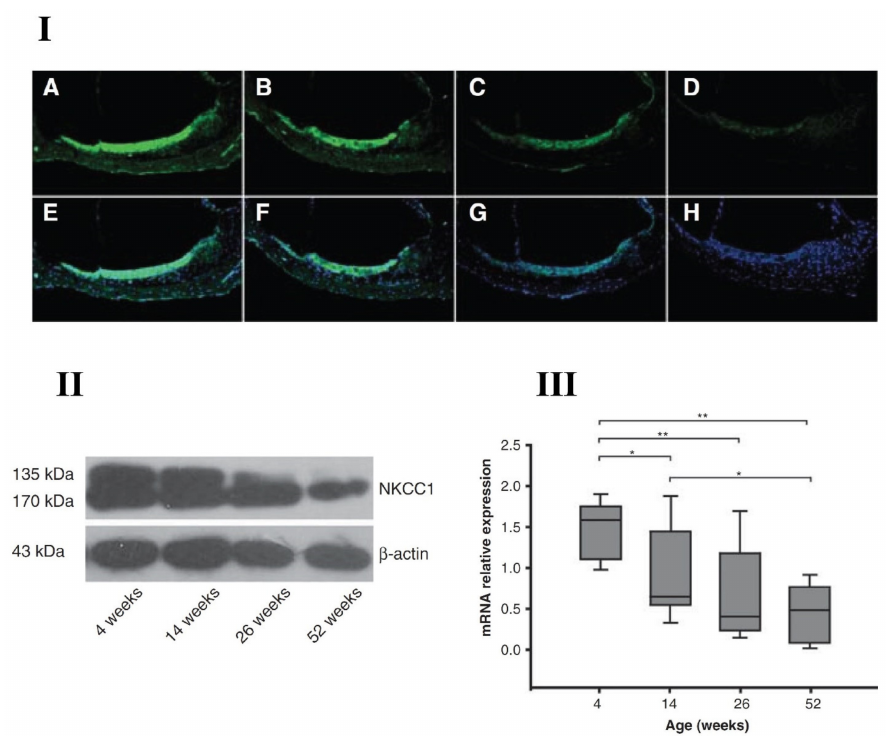
Figure 2. Aging decline of NKCC1 (sodium-potassium-chloride cotransporter) in C57BL/6J mouse cochlear lateral wall with four different age-group animals; 4 weeks old, 14 weeks old, 26 weeks old and 52 weeks old. ( I ) Age-related changes of NKCC1 protein stain with FITC (Fluorescein isothiocyanate, green fluorescence—top row) and the nuclei counter stained by DAPI (4 (cid:48) ,6-diamidino- 2-phenylindole, blue fluorescence—bottom row) for 4 animal groups at 400 × magnification; A, E—4-week-old group; B,F—14-week-old group; C, G—26-week-old group and D, H—52-week-old group. ( II , III ) Western blotting and real-time polymerase chain reaction (RT-PCR) results from the four different age groups showed the gradual reduction in NKCC1 at both protein and gene expression levels. * p < 0.05, ** p < 0.01. From Liu et al. (2014) [55], with permission from the